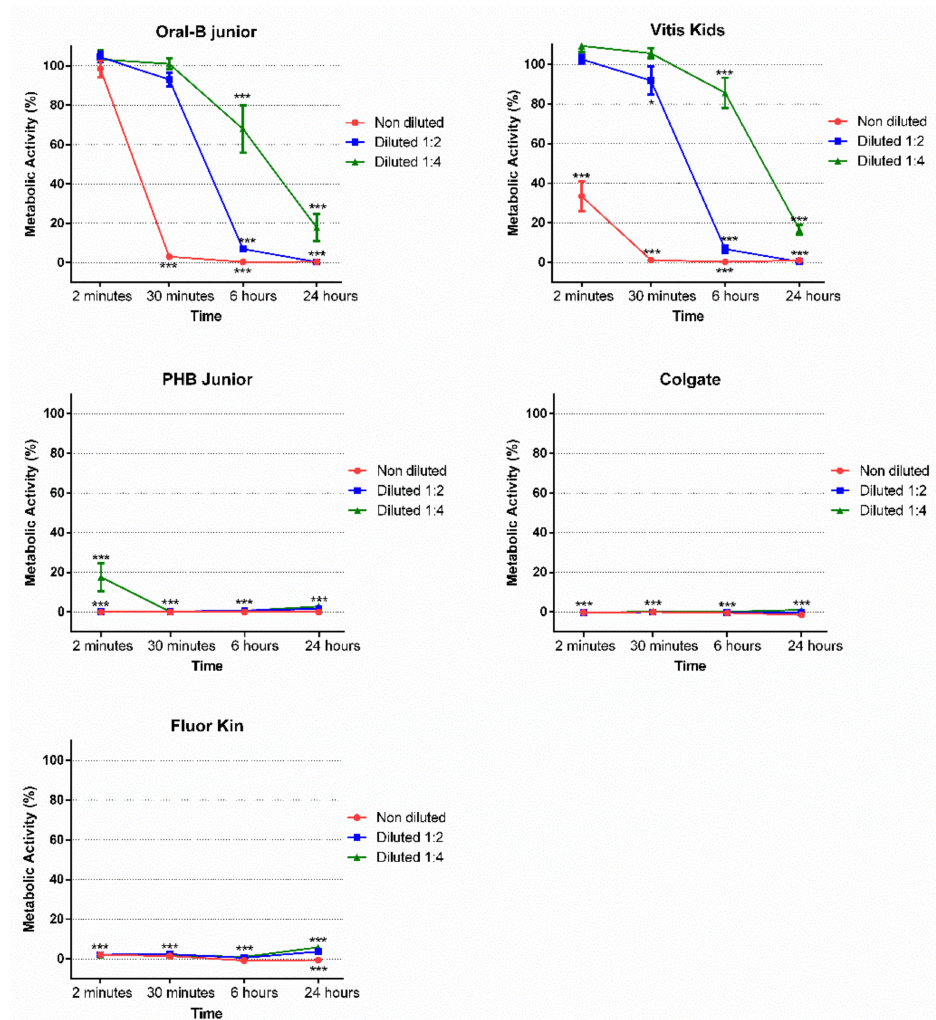
Figure 1. Metabolic activity of hGFs treated with different children’s toothpaste concentrations (1:1, 1:2, 1:4) for 2 min, 30 min, 6 h and 24 h (* p < 0.05, *** p < 0.001) according to one-way ANOVA and Tukey’s post hoc